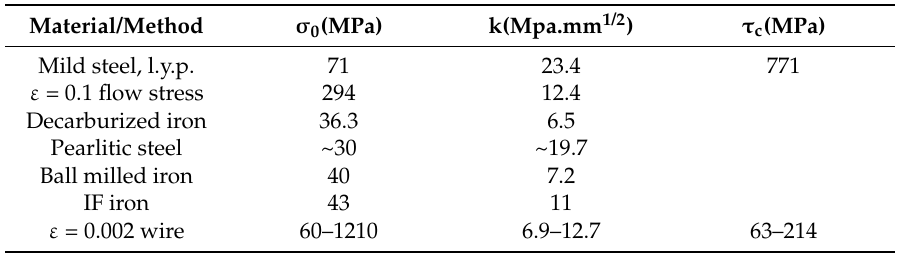
Table 1. Hall-Petch parameters for iron and steel materials.